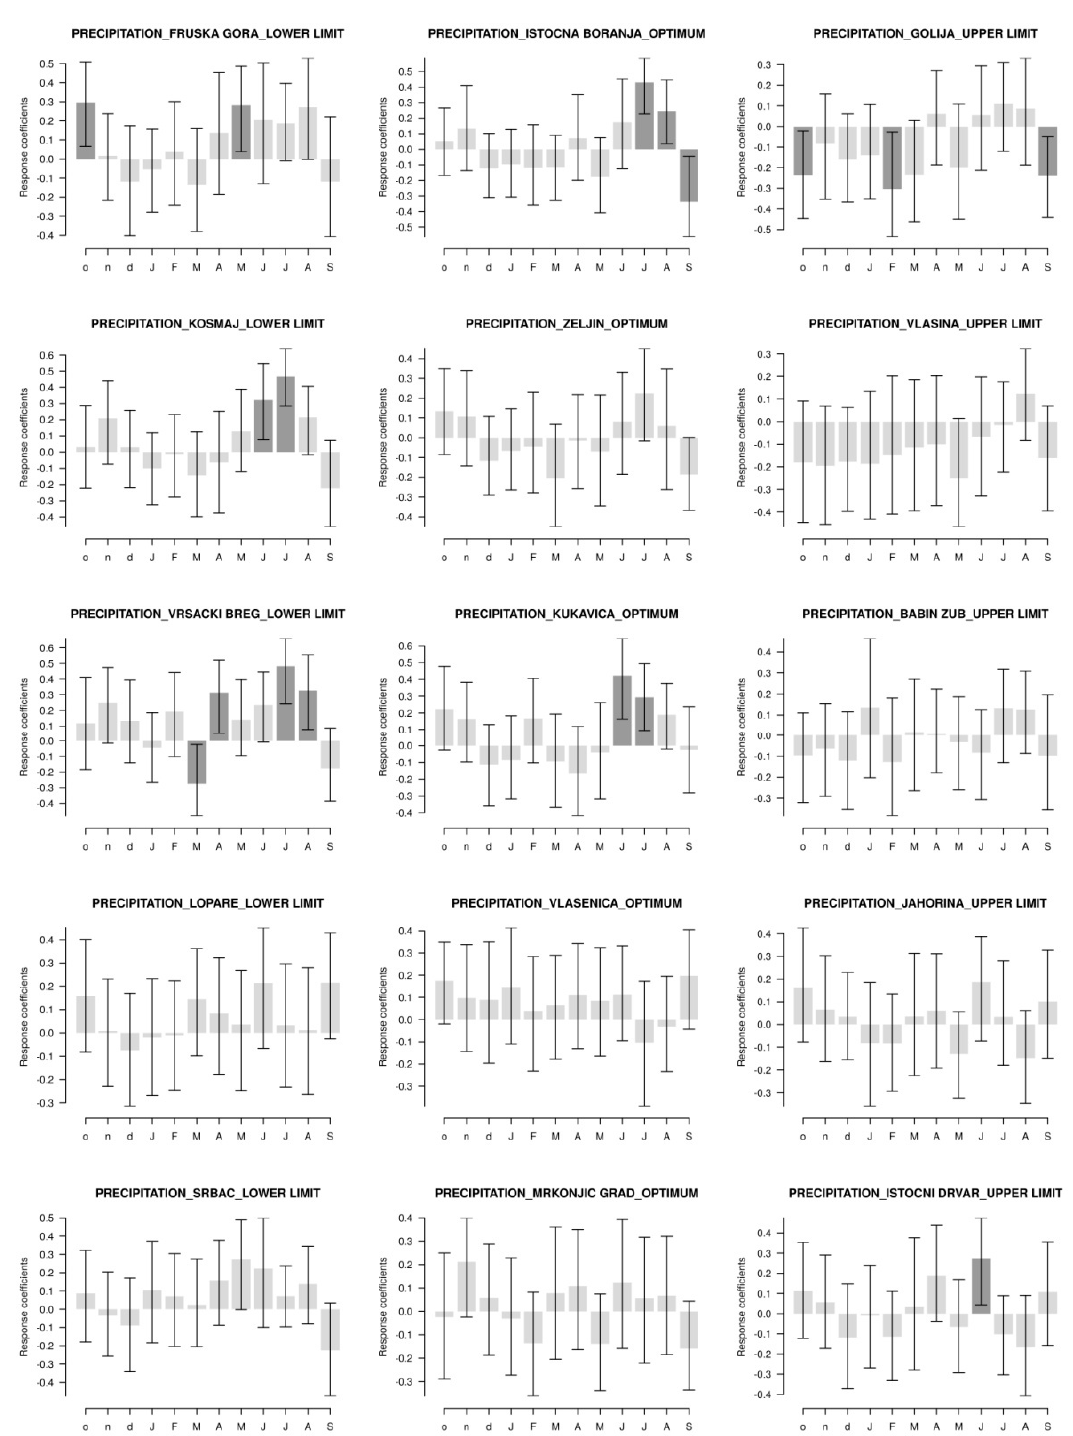
Figure 6. Bootstrapped Pearson’s correlation between tree-ring width and precipitation in the period 1951–2013 (2015) for the different elevations. Months marked by small letters are from the year prior to the growth and capital letters represents the year of the growth. Dark color represents significant correlation at p < 0.05.